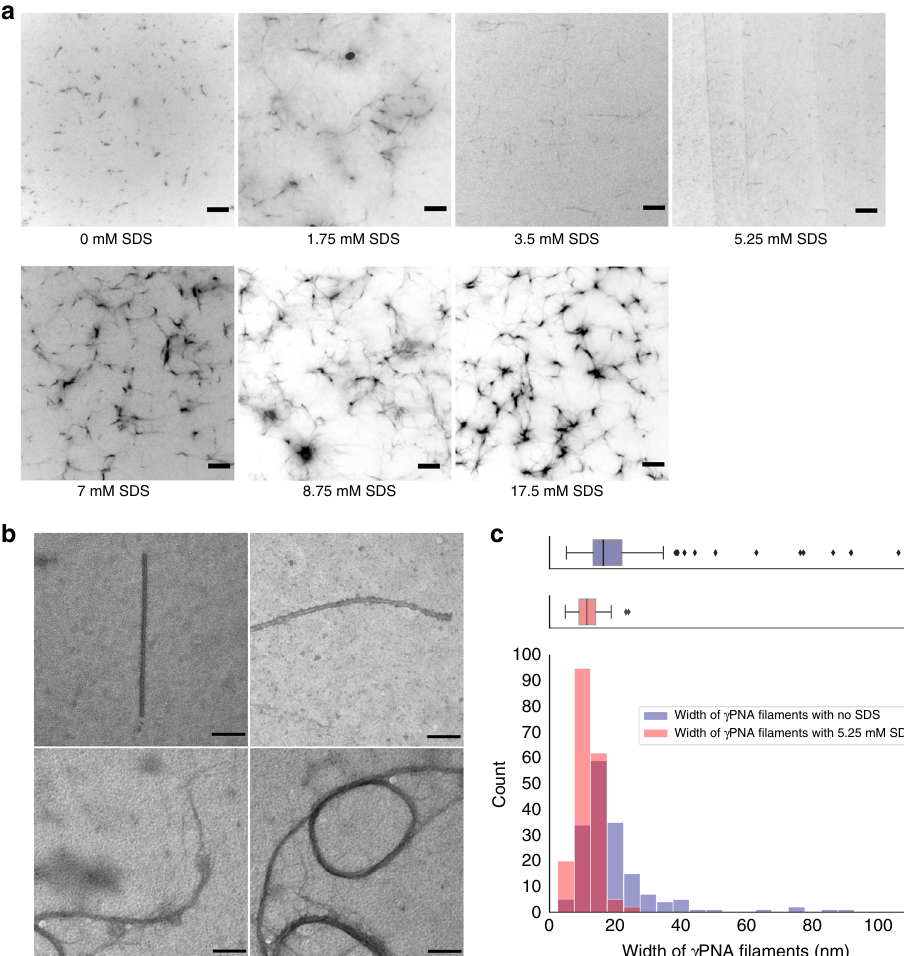
Fig. 4 Effect of SDS on the width of γ PNA nano fi bers during self-assembly using TIRF and TEM assays. a TIRF panels (5 μ m scale bar) of the self- assemblies formed by γ PNA in 75% DMSO:H 2 O (V V − 1 ) with different concentration of SDS ranging from 0 to 17.5 mM (repeated over 2 independent experiments for each condition). With increasing concentrations of SDS [0 – 5.25 mM], thinner morphologies of the nano fi bers become more dominant. When concentrations of SDS neared or exceeded the CMC concentration (8.2 mM), networked morphologies of γ PNA with increasing propensity was observed. b TEM panels (100 nm scale bar) of γ PNA nanostructures annealed in 75% DMSO:H 2 O (V V − 1 ) with 5.25 mM SDS shows nano fi bers with diameters of 8 – 12 nm range. c Overlay of width distribution of γ PNA nanostructures with 5.25mM SDS (sample size, N = 185 visibly separate nanostructures over 2 independent experiments, red) and without SDS (sample size, N = 171 visibly separate nanostructures over 4 independent experiments, blue) using TEM studies. Nano fi bers in the presence of 5.25 mM SDS show a tight distribution with a median width of 11.3 nm and IQR of 5 nm. Source data are provided as a Source data fi